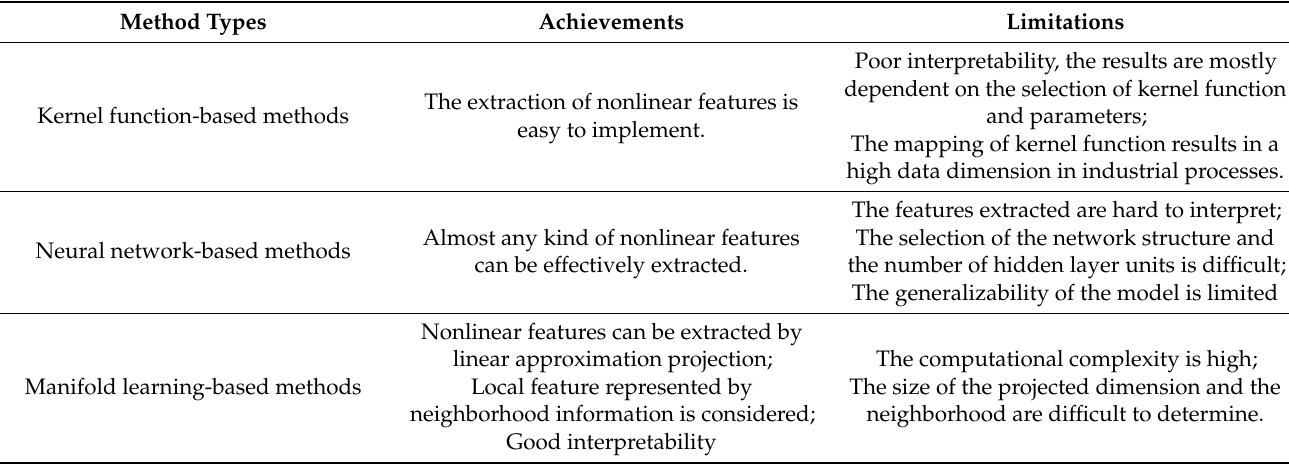
Table 5. Comparative analysis of nonlinear process monitoring